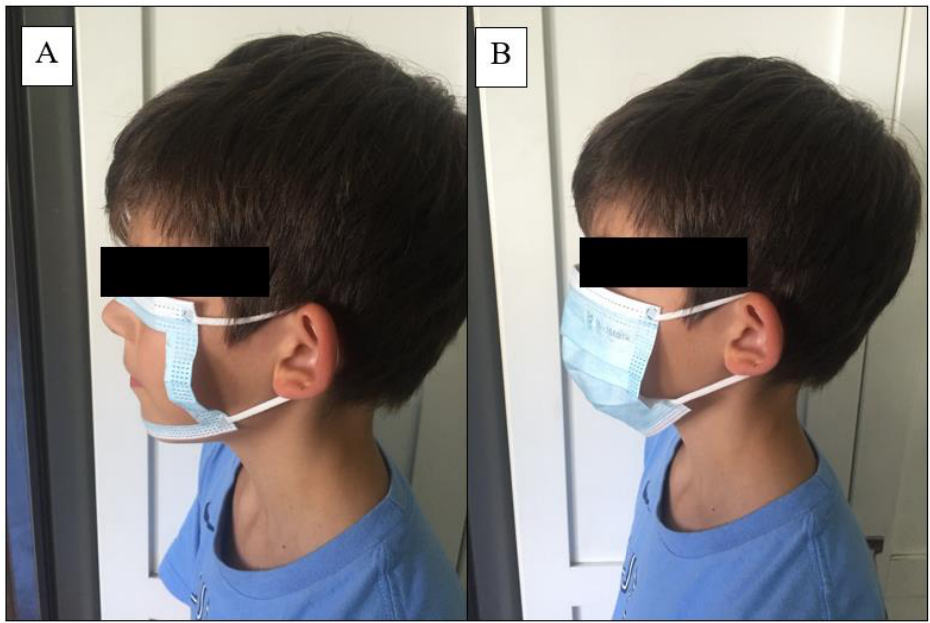
Figure 1. Fitting of the sham ( A ) and regular ( B ) masks (photo use by permission).